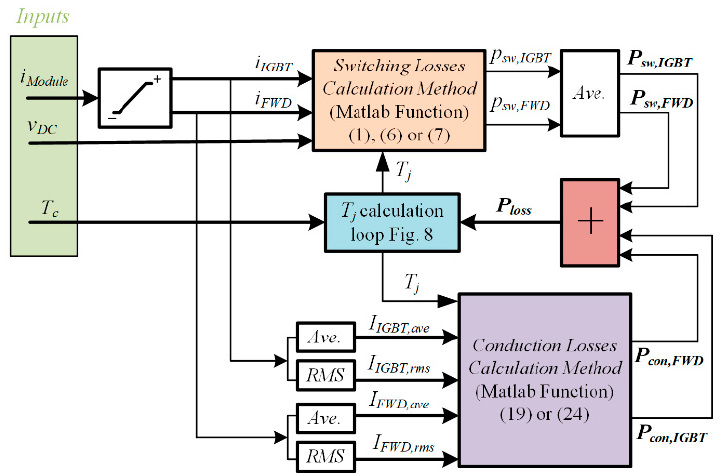
Figure 9. Implementation of losses calculation methods in Matlab Simulink.